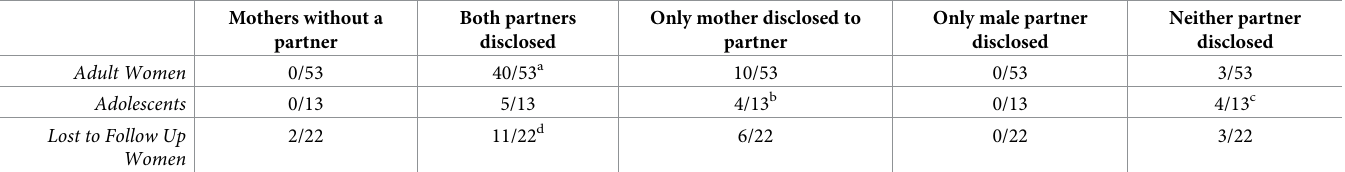
Table 3. Disclosure amongst couples (qualitative